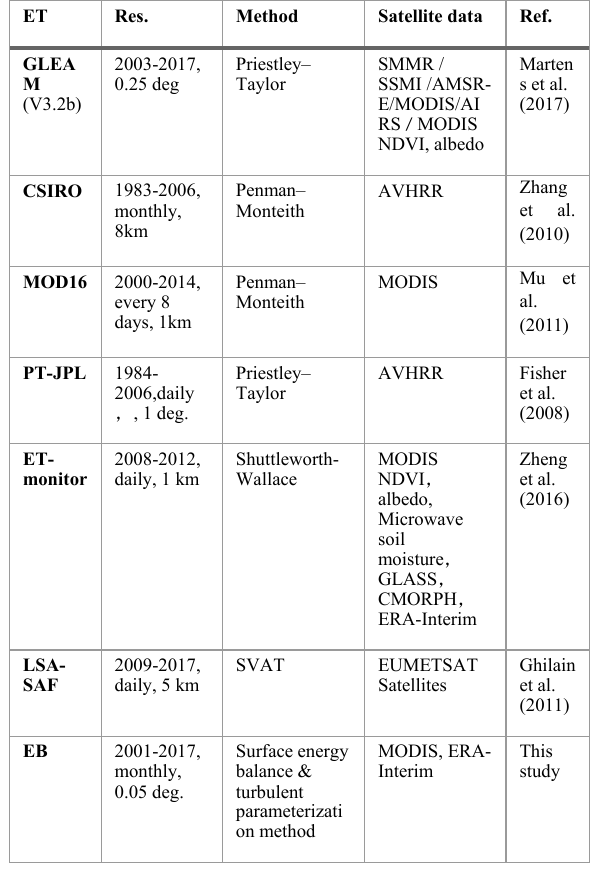
Table 3: Available global/continental ET products based on satellite data